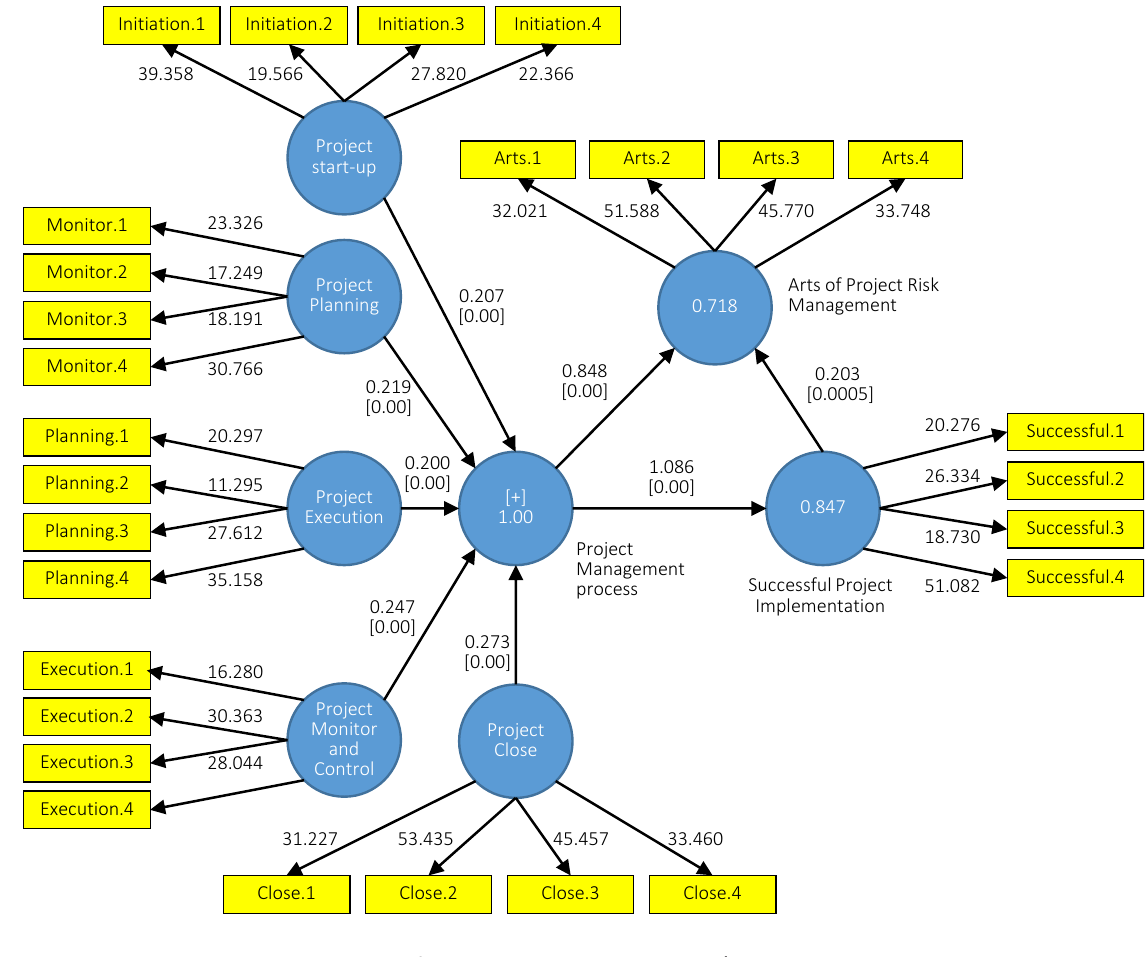
Figure 3. Bootstrapping